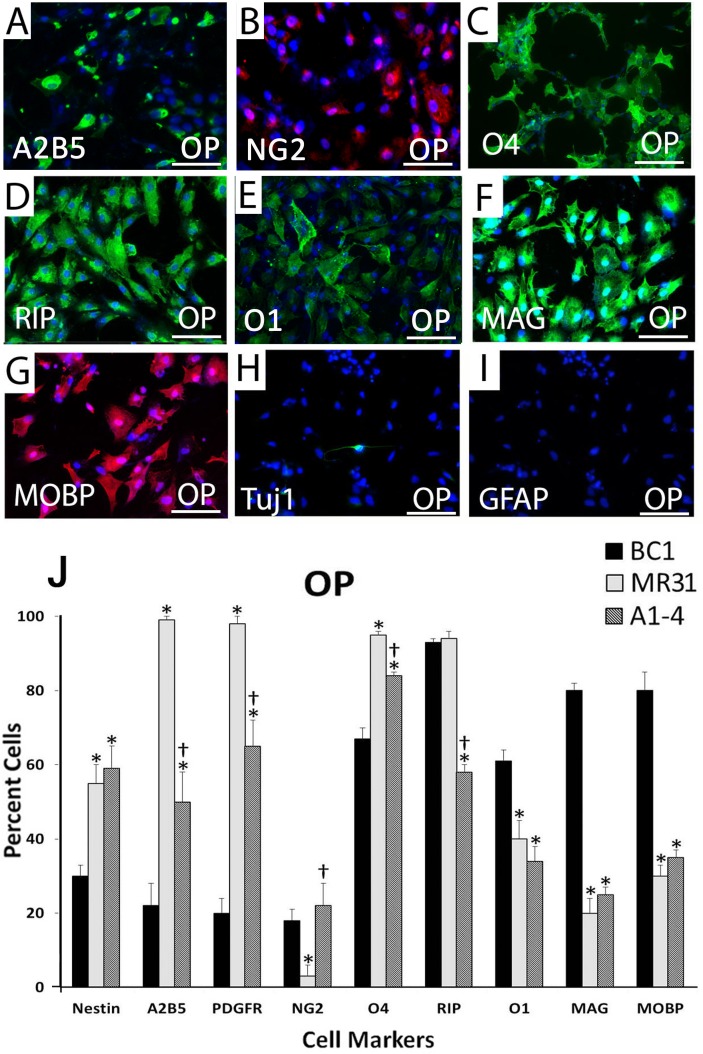
Indirect immunofluorescence marker characterization of oligodendrocyte progenitors derived from human iPS cells.Nuclei were stained with DAPI (blue). Results show reduced expression of early markers (A) A2B5 and (B) NG2 and increased protein expression of mid to late oligodendrocyte progenitor (OP) differentiation markers (C) O4 (D) RIP (E) O1 (F) myelin-associated glycoprotein (MAG) and (G) myelin-associated oligodendrocytic basic protein (MOBP). Myelin basic protein (MBP) expression was not detectable by immunostaining. 1% or less of OP cells expressed markers of other neural lineages as denoted by (H) the neuronal maker neuron-specific class III beta-tubulin (TUJ1) and (I) the astrocyte marker glial fibrillary acidic protein (GFAP). (J) Quantification of the indirect immunofluorescence analyses calculating the percent of cells expressing a particular marker is shown in the lower panel. A higher percent of cells derived from BC1 expressed later OP markers MAG, MOBP and O1 while fewer cells from the BC1 lines expressed early neural progenitor (NP) and glial progenitor (GP) markers and early OP marker O4 compared to MR31 and A1-4. Differentiation of each cell line was performed in triplicate and the percent of positively stained cells was determined from 3 randomly, chosen 10X fields per 24-well cell culture dish from all three replicates. Values in the graphs represent mean ± SEM. * and † denote statistical significance compared to BC1 and MR31, respectively by ANOVA and Tukey post hoc tests (N = 9, P < 0.001). Scale bars: 100 μm.